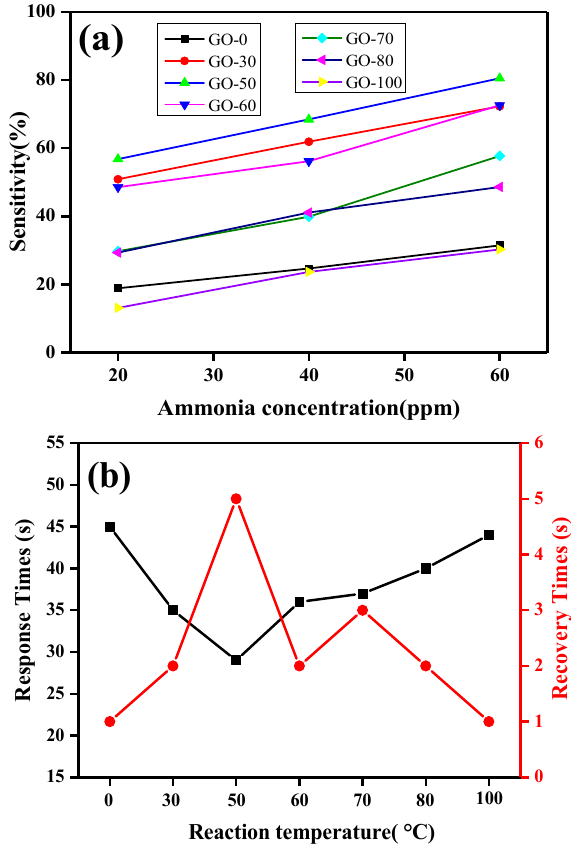
Figure 10. Sensitivity change of graphite oxide and response recovery time curve at 20 ppm ammonia: ( a ) Sensitivity change, ( b ) Response recovery time.